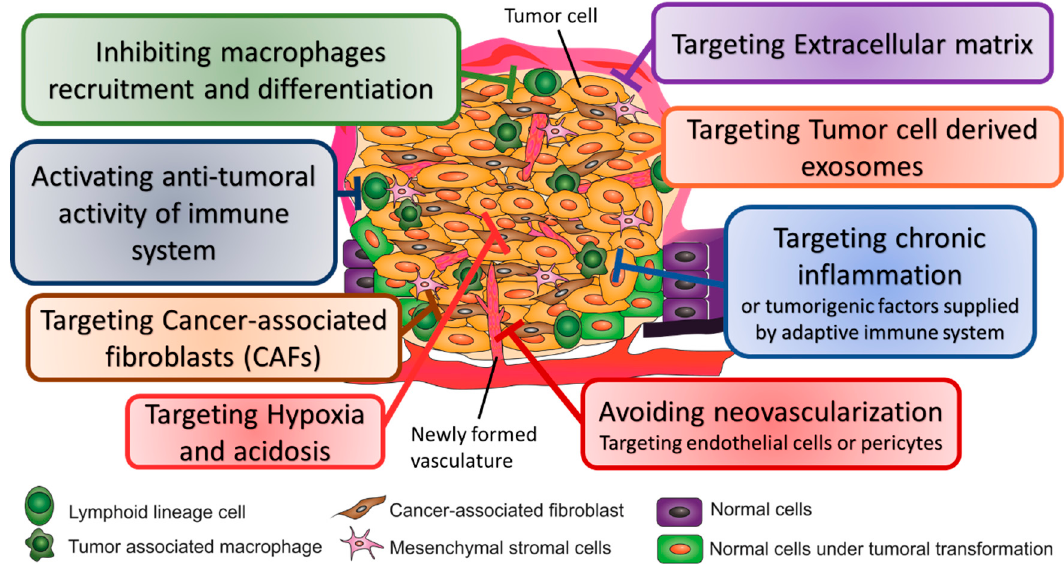
Figure 2 . Strategies used to target tumor microenvironment for cancer therapy. Figure 2. Strategies used to target tumor microenvironment for cancer